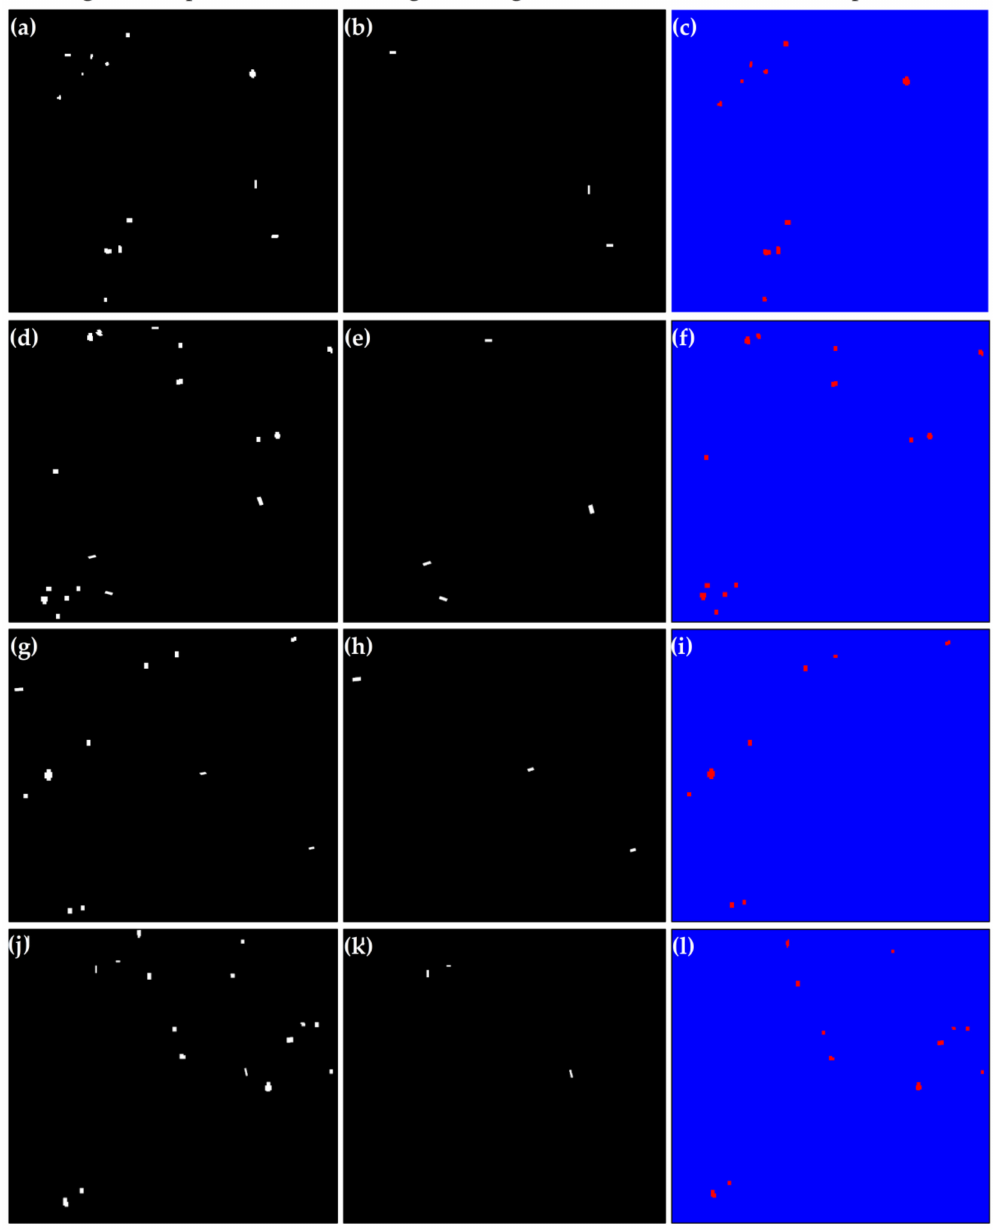
Figure 7. Results of the automatic extraction of offshore platforms in the four study areas, where ( a – c ) represent study area 1, ( d – f ) represent study area 2, ( g – i ) represent study area 3, and ( j – l ) represent study area 4. ( a , d , g , h ) show the two-parameter constant false alarm rate (CFAR) detection results of study areas 1–4, ( b , e , h , k ) show the Hough detection results of study areas 1-4, and ( c , f , i , l ) show the final potential offshore platform extraction results of study areas